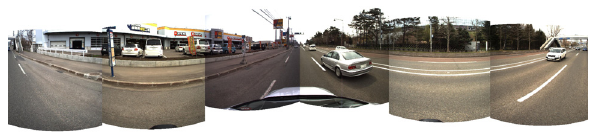
Figure 9. Colour tone difference among MMS cameras